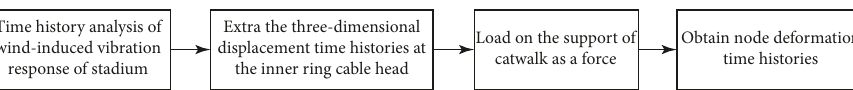
Figure 22: Analysis method of the wind-induced response of the circular catwalk. Table 3: The maximum expansion of the type 1 node.